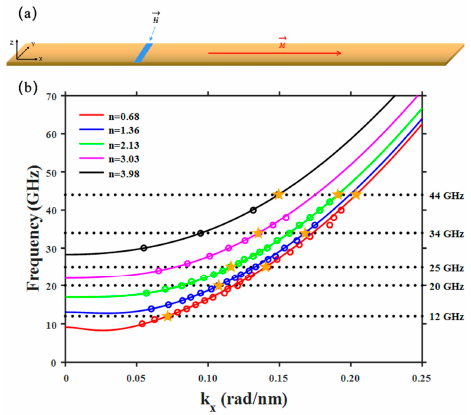
Figure 1. ( a ) A Permalloy thin-film strip magnetized along the positive x axis serving as an SW guide. An oscillating field is applied at the blue region to excite SWs. ( b ) Dispersion relations of SWs with different order numbers n . The dots are numerical data obtained in simulations while the solid lines are fittings using Equation (2). The dashed lines help to indicate the degeneracy of modes. The yellow stars indicate degenerate modes that in principle can be co-excited by a partic- ular oscillating field. 3. Results Before showing our simulation results, we will first explain the dispersion curves of SW modes traveling in a thin-film strip and its influence on the excitation of SWs. Due to the lateral confinements in the transversal direction ( y axis in Figure 1a), the corre- sponding wave vector is quantized, given by 𝑘 (cid:3052) =𝑛𝜋 𝑤⁄ , where w is the width of the strip and n a positive integer, defining the order number of the standing wave formed in the transversal direction [28]. For each n , there is a dispersion curve with respect to the continuous wave vector 𝑘 (cid:3051) in the longitudinal direction of the strip ( x axis in Figure 1a), thus yielding a multi-branched structure (can be seen in Figure 1b). We point out that a quantization in the thickness direction ( z axis in Figure 1a), which would result in much higher frequency, is ignored in our consideration. In simulations or experiments, one may excite a monochromatic SW mode by ap- plying an oscillating field with a particular frequency. However, the frequency degen- eracy of SW modes with different order numbers n leads to multiple excitations simul- taneously, resulting in branch hybridizations. In our simulations, we applied local fields with specially designed spatial distributions to maximally couple to a mode with a par- ticular order number [29]. For instance, a field uniformly distributed across the strip is supposed to excite a n = 1 mode. By varying the frequency and shape of the oscillating fields, the dispersion curves with respect to 𝑘 (cid:3051) can be calculated numerically. The re- sults obtained are drawn in Figure 1b (dots), showing five dispersion curves in total ( n = 1~5).